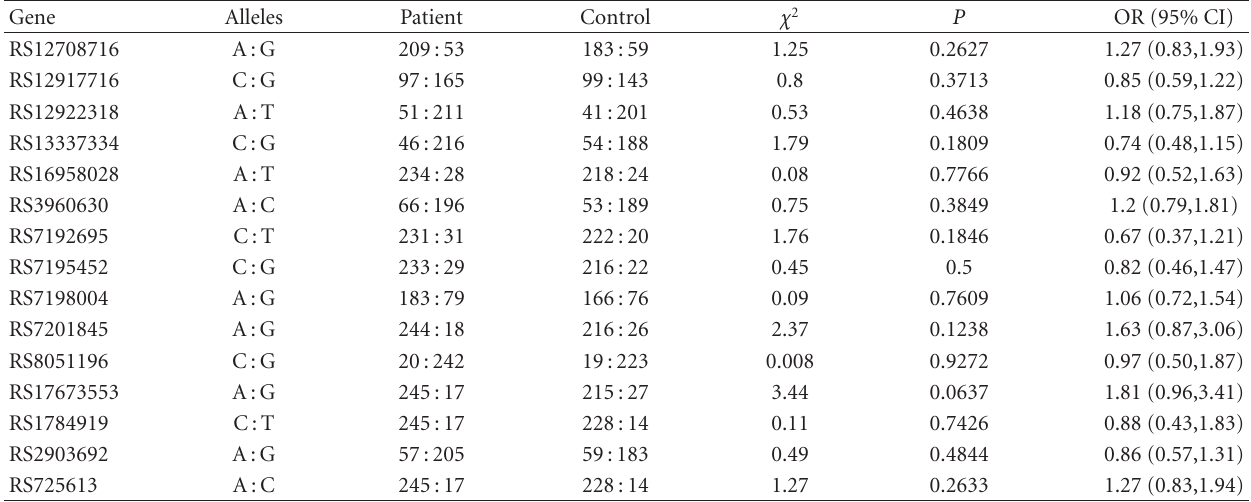
Table 3: Frequency distribution of the alleles at the 15 loci of the CLEC16A gene without statistical significance in Chinese children with TIDM and healthy control